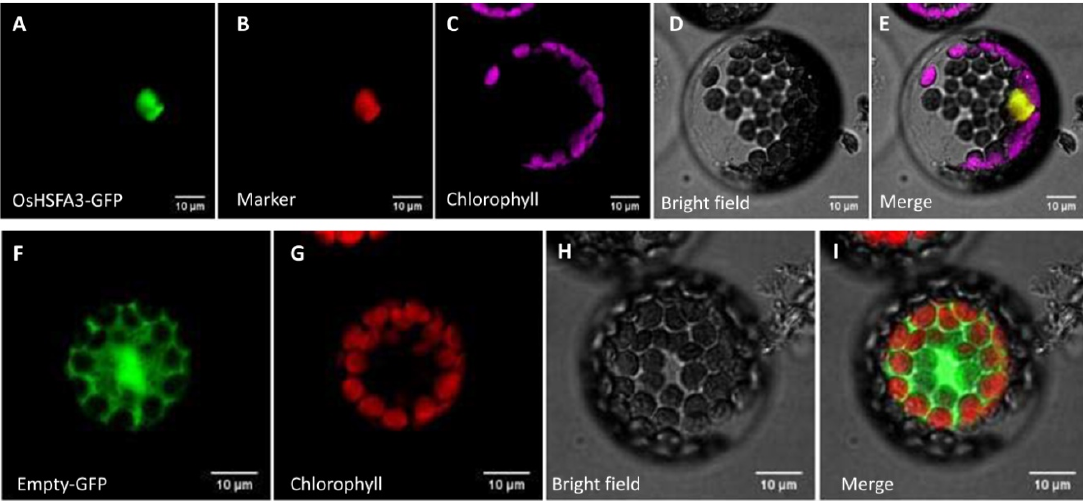
Figure 2. Subcellular localization of OsHSFA3 protein. Arabidopsis protoplasts were transiently transformed with constructs containing either OsHSFA3 fused with green fluorescent protein (GFP) ( A – E ) or GFP alone ( F – I ).